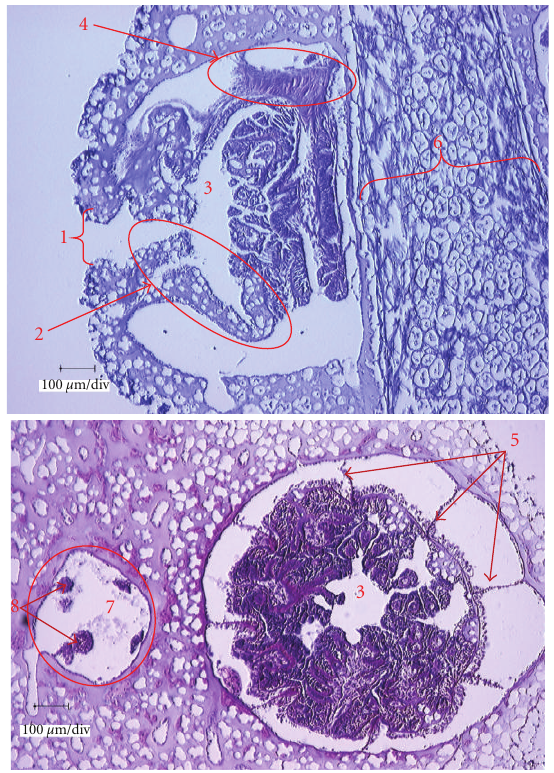
Figure 19: Longitudinal section (above; OCA-Cn20090413-047) and transverse section (below; OCA-Cn20060214-041) of auto- zooid of Corallium elatius . 1: mouth opening, 2: tentacle, 3: gastric cavity, 4: muscular tissue, 5: septum, 6: axis, 7: siphonozooid, 8: gamete (sperm sac).